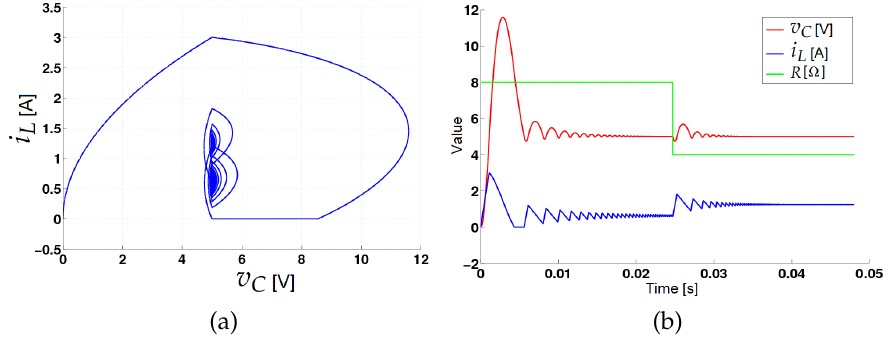
Figure 20. Dynamics with load perturbations: ( a ) phase plane and ( b ) temporal response.